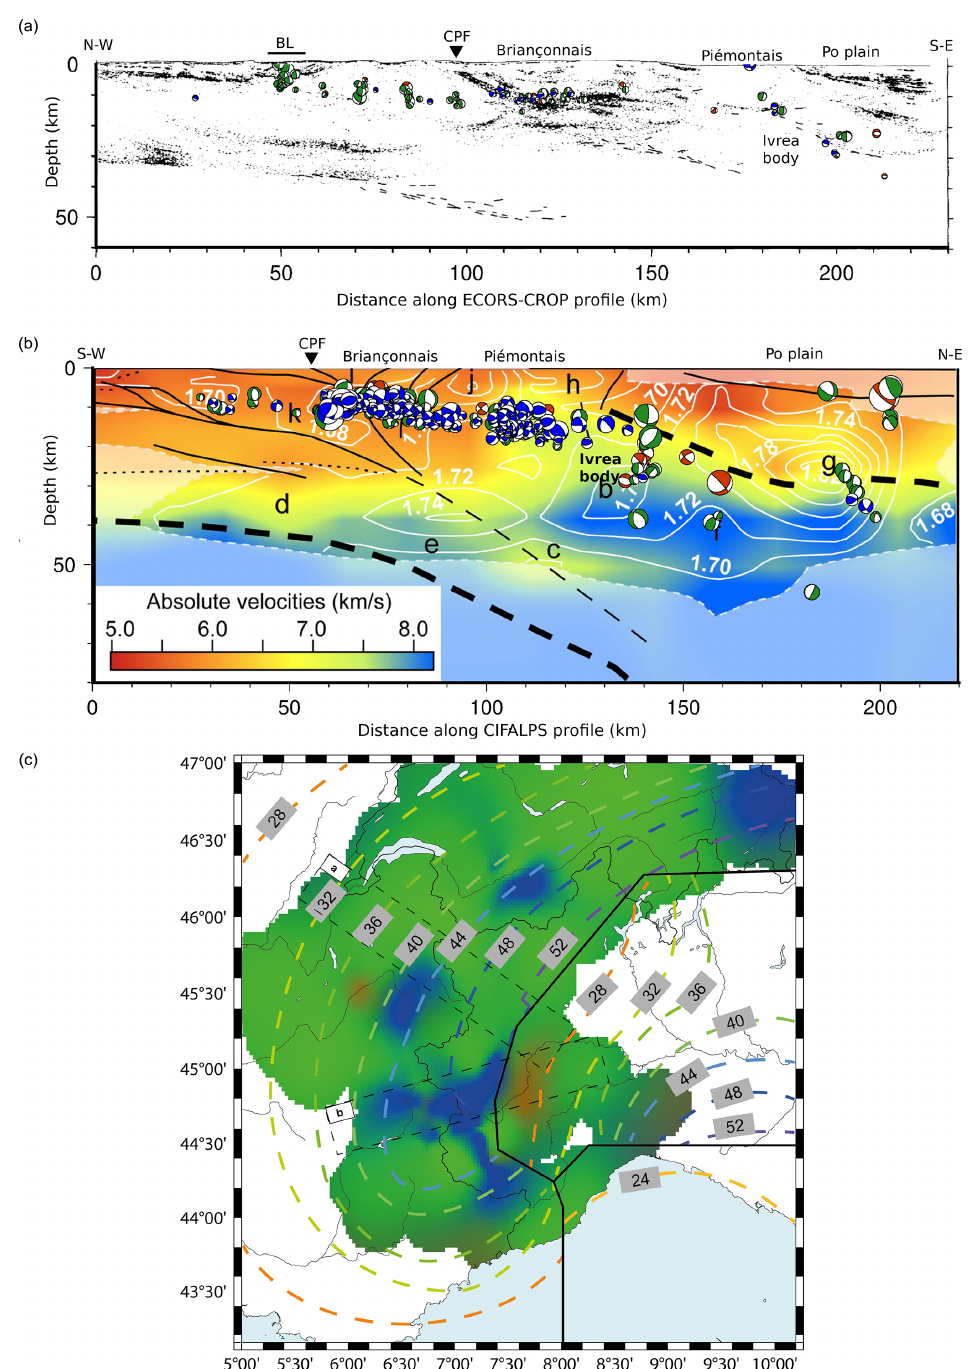
Figure 10. (a) Cross section of computed focal mechanisms (vertical sections) projected on an ECORS-CROP seismic reflection profile (see projection width in c ), modified from Marchant and Stampfli (1997). Green, blue, and red are for strike-slip, normal, and reverse mechanisms, respectively. Labels refer to geological features displayed in Fig. 3. (b) Focal mechanism (vertical sections) cross section projected on a CIFALPS profile (see projection width in c ) of local earthquake tomography, modified from Solarino et al. (2018) and colour-coded as in (a) . White contours are isolines of equal V p /V s , solid lines represent main tectonic features, and bold letters refer to different regions of the model discussed in Solarino et al. (2018). Thick dashed lines represent European and Adriatic Mohos following Solarino et al. (2018). The Adriatic Moho is deflected west of the Po plain ( ∼ 15km depth) at the location of the Ivrea body gravimetric anomaly. (c) Contours of Moho depth (in km) from Spada et al. (2013) superposed on the map of deformation style from Fig. 7. The European Moho (to the west), the Adriatic Moho (to the east), and the Ligurian Moho (to the south) are separated by thick black lines. The location of the seismic profiles (a) and (b) are indicated by dashed